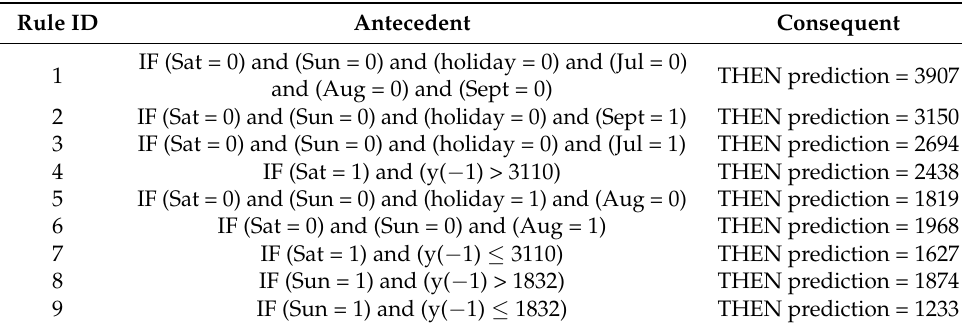
Table 4. Surrogate rules obtained for the LSTM model.